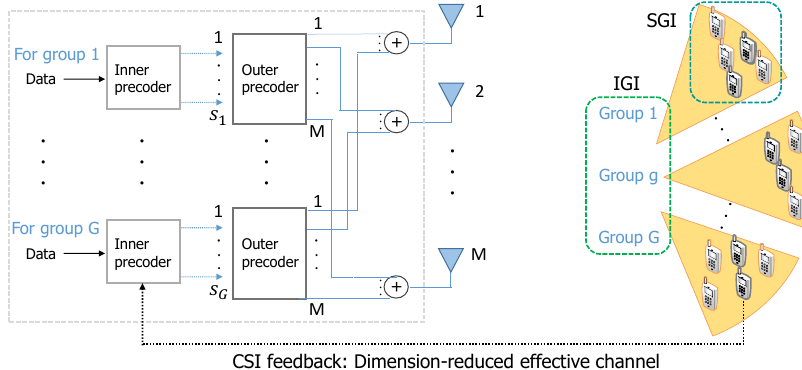
Figure 2. Illustration of the two-stage precoder with limited